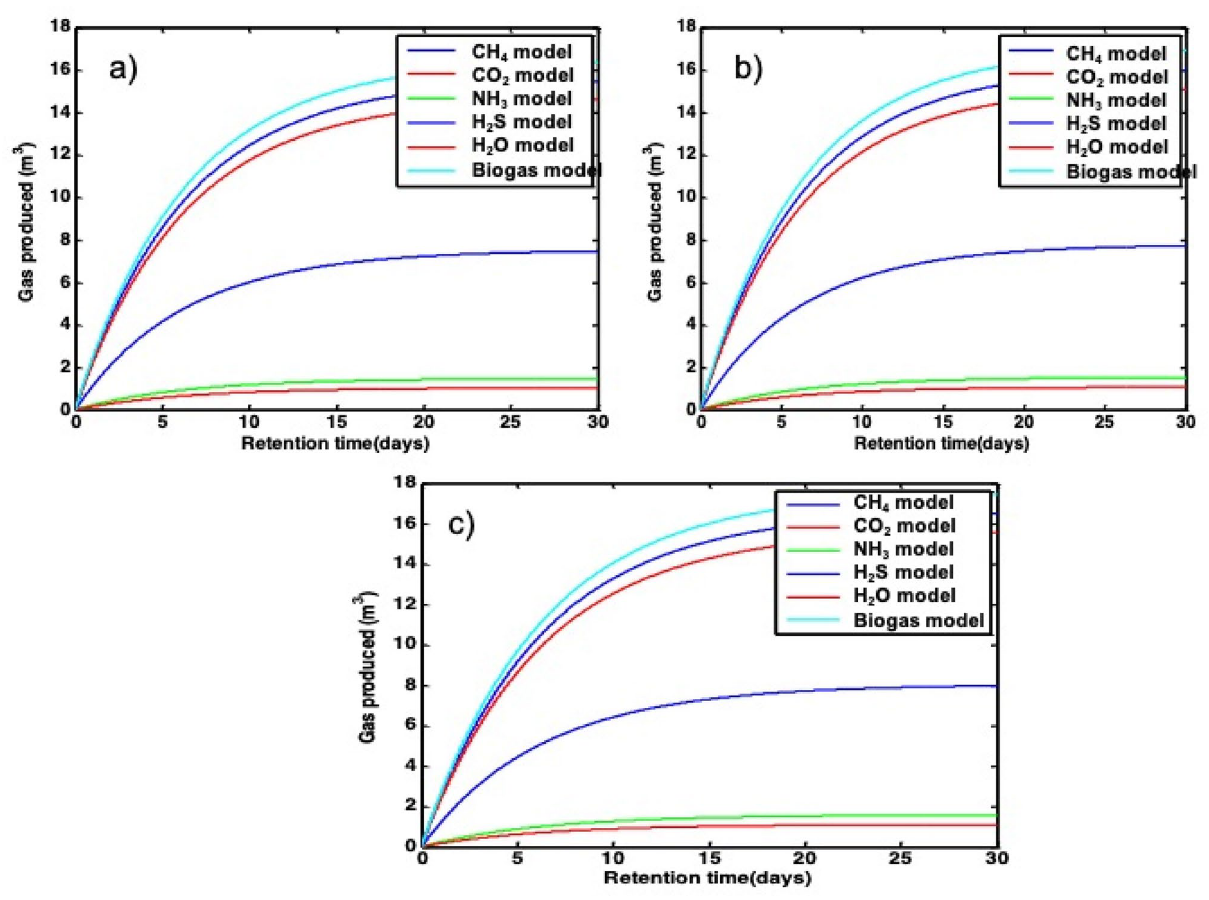
Figure 8. Simulation results of biogas production as a function of retention time (days) at various temperatures of ( a ) 45 ℃ , ( b ) 35 ℃ , and ( c ) 25 ℃ ,